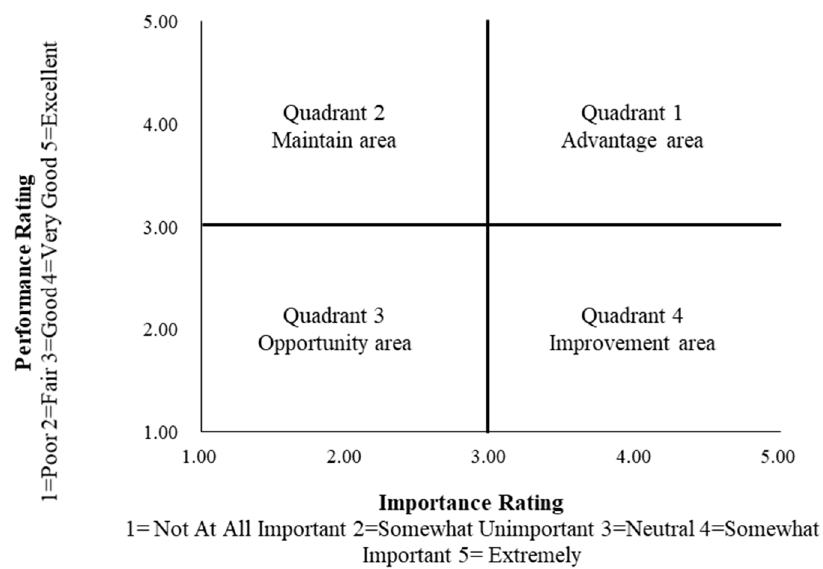
Figure 5. Scheme of importance–performance analysis grid.